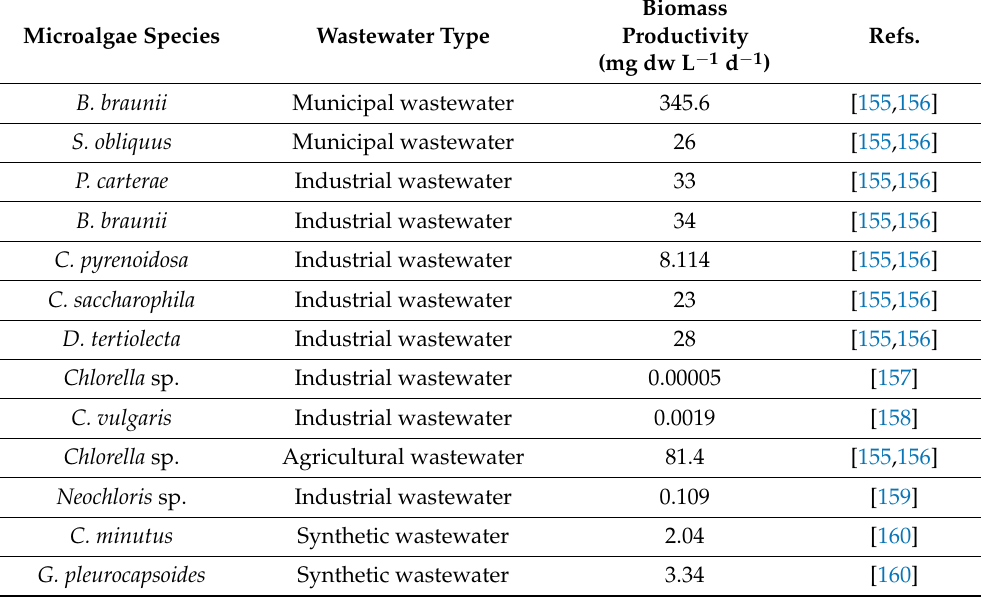
Table 7. Biomass productivity of microalgal species cultured in wastewater.